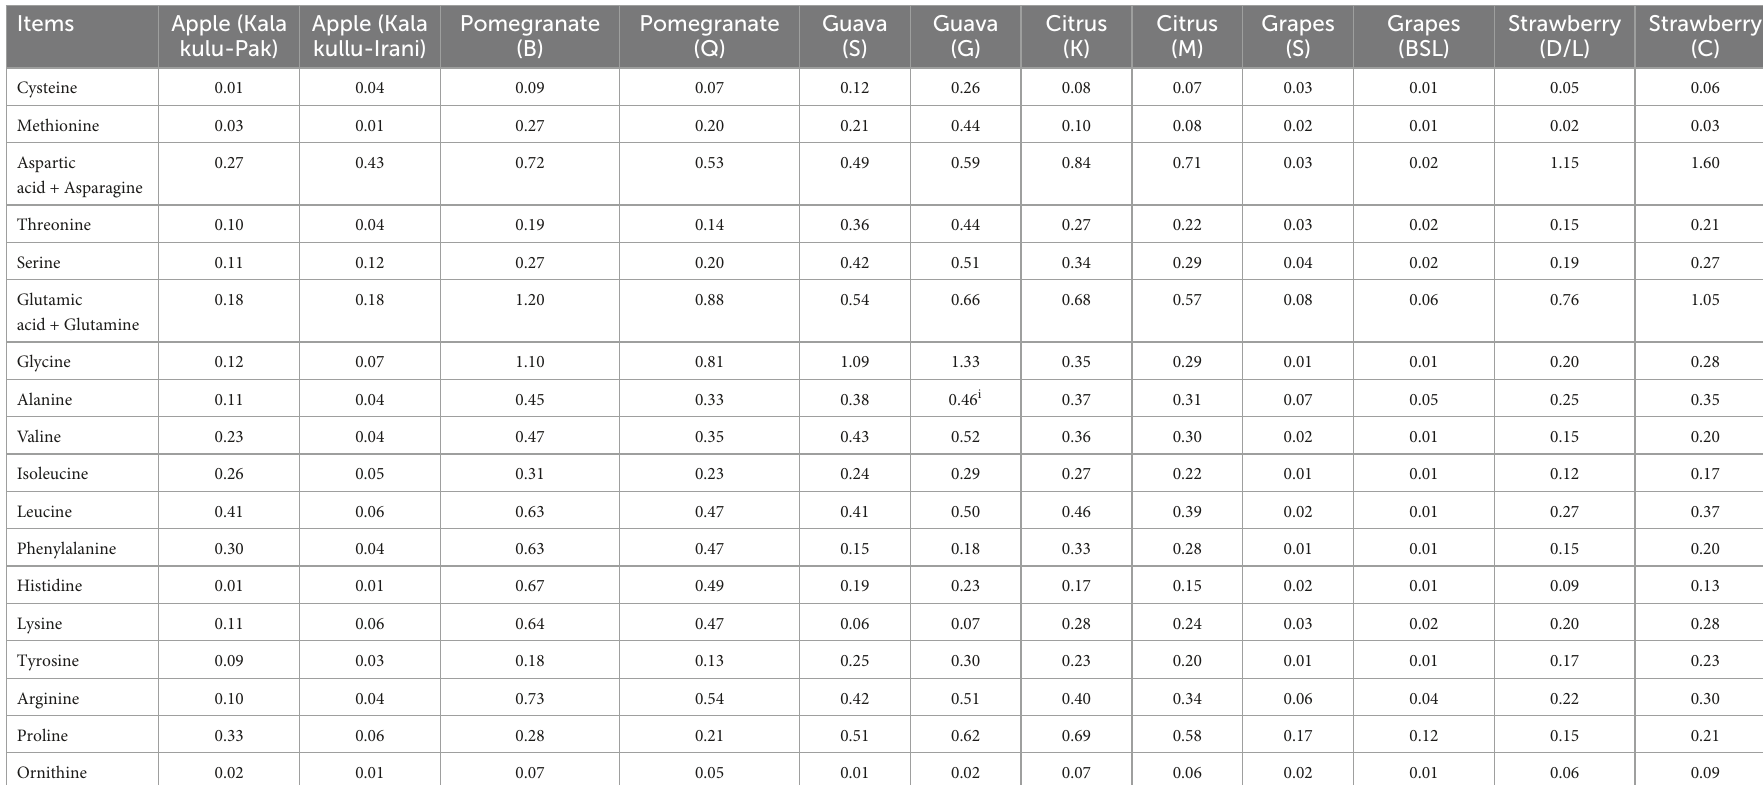
TABLE 3 The amino acid profile of different fruit peel varieties [dry matter basis (%)].